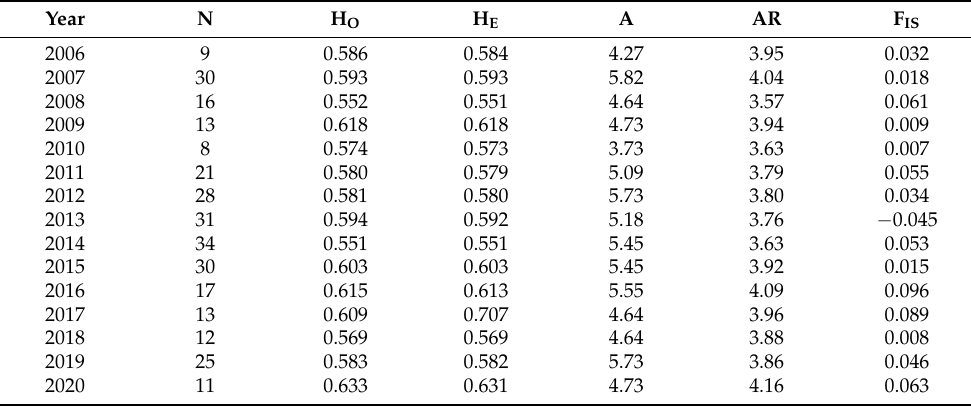
Table 2. Nuclear genetic diversity estimates of 11 microsatellite loci for yearly resampled chick datasets. Number of samples, observed (H O ) and expected (H E ) heterozygosities, number of alleles (A) and allelic richness (AR) based on a minimum of seven diploid individuals, and